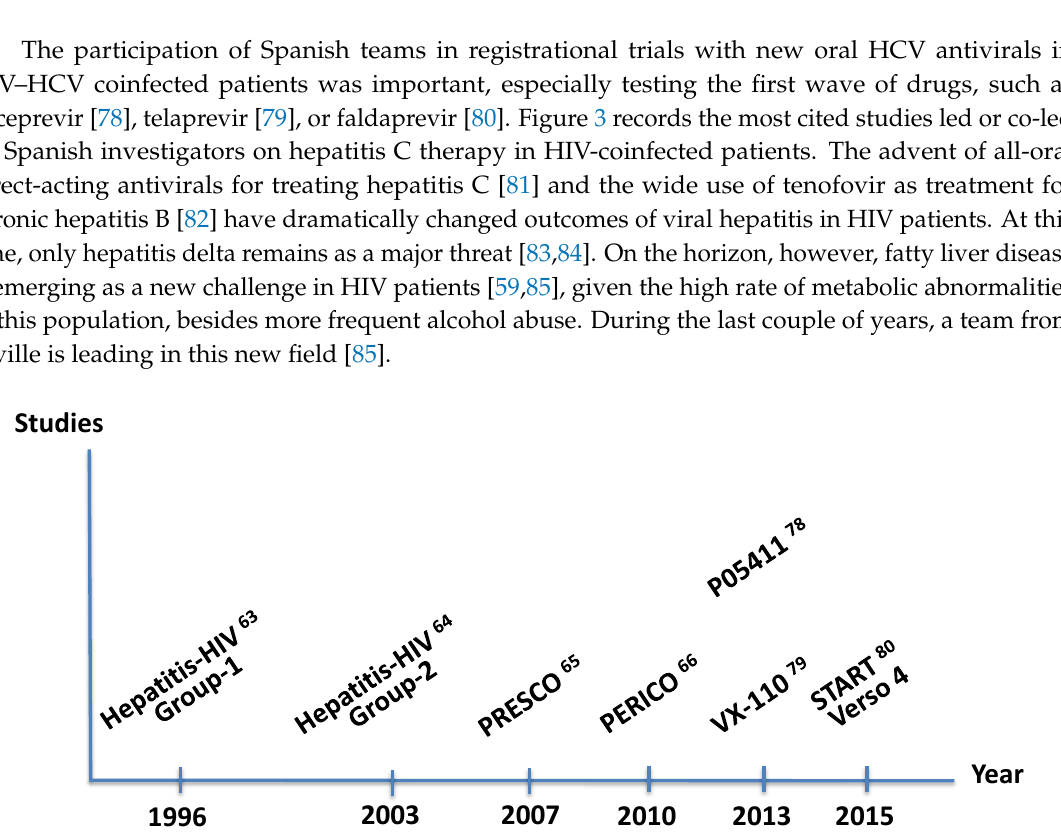
Figure 3. Major prospective clinical trials on treatment of hepatitis C in HIV coinfection led by Spanish researchers.